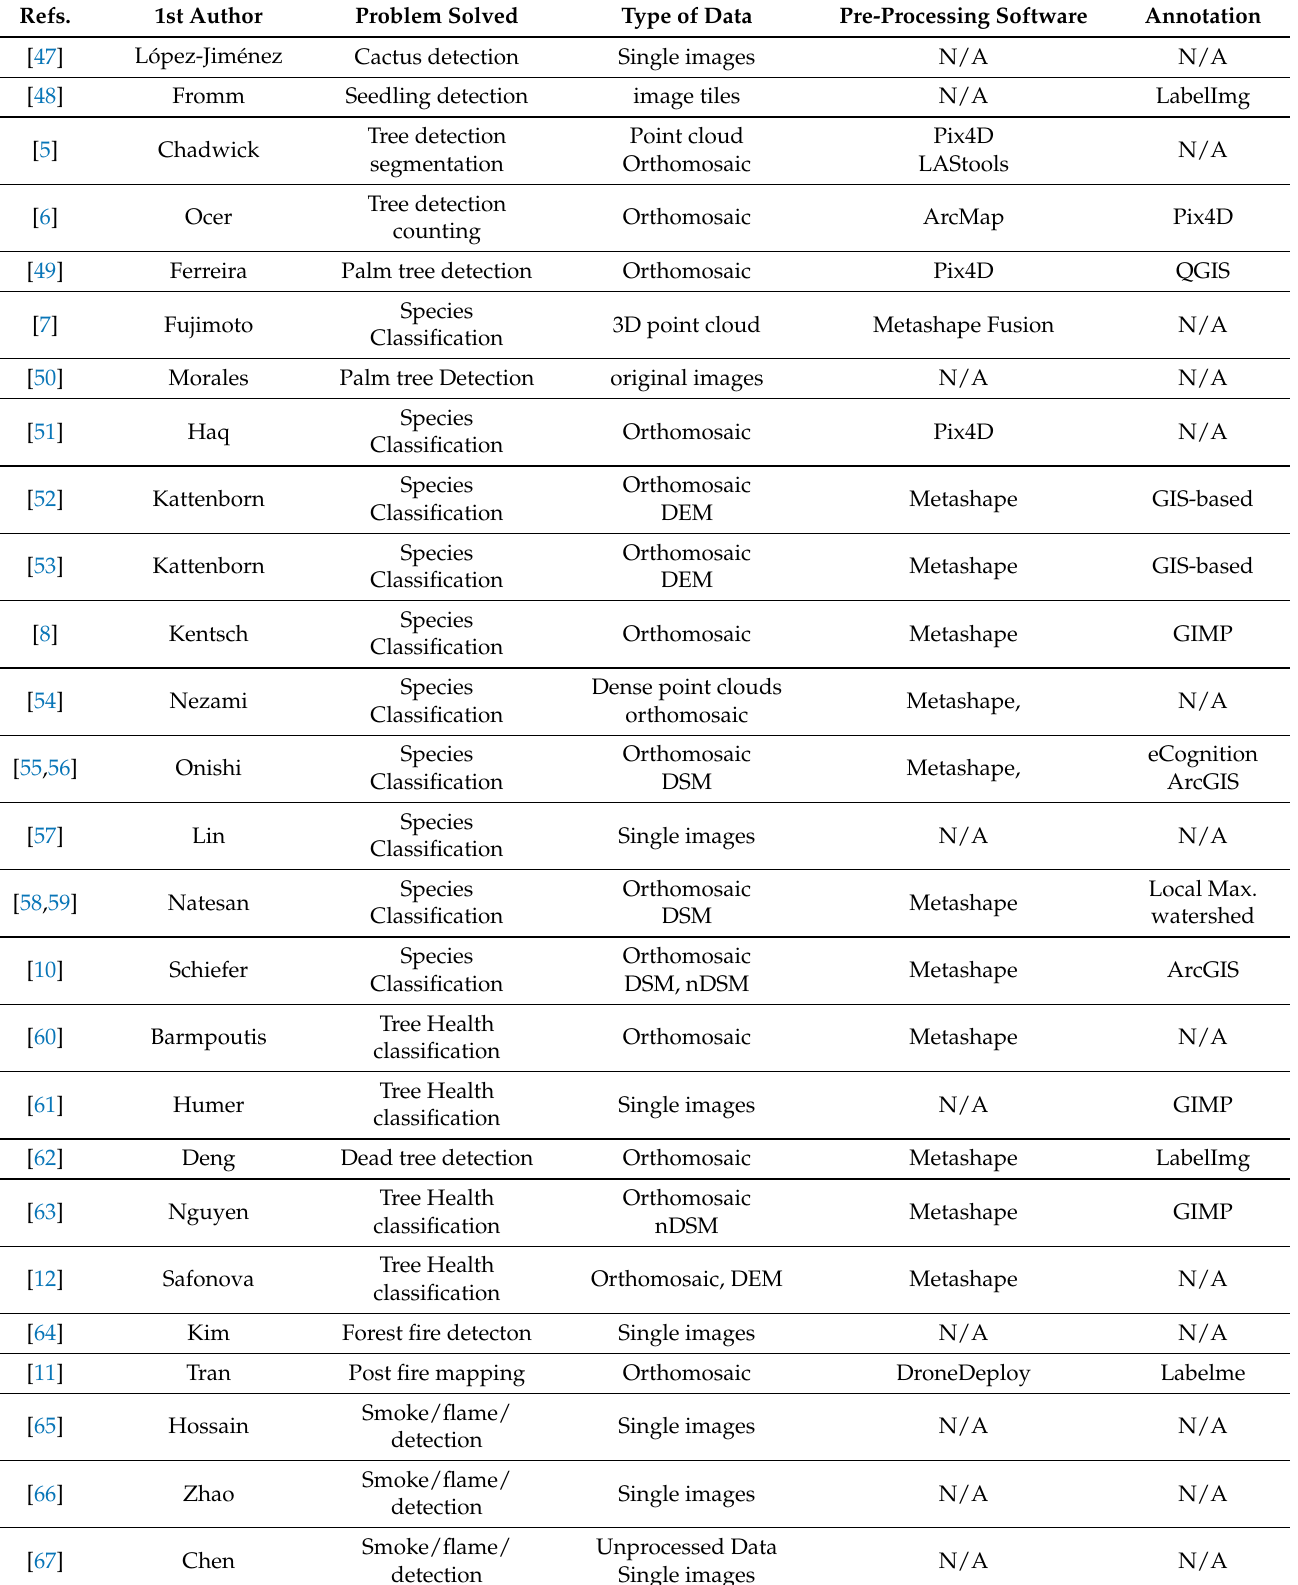
Table 1. Summary of pre-processing and annotation software used in the reviewed papers.